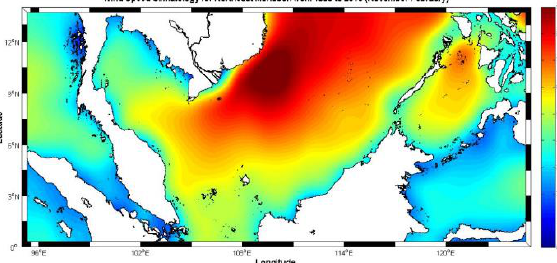
Figure 8. Average of wind speed during Northeast Monsoon from 1993 to 2016